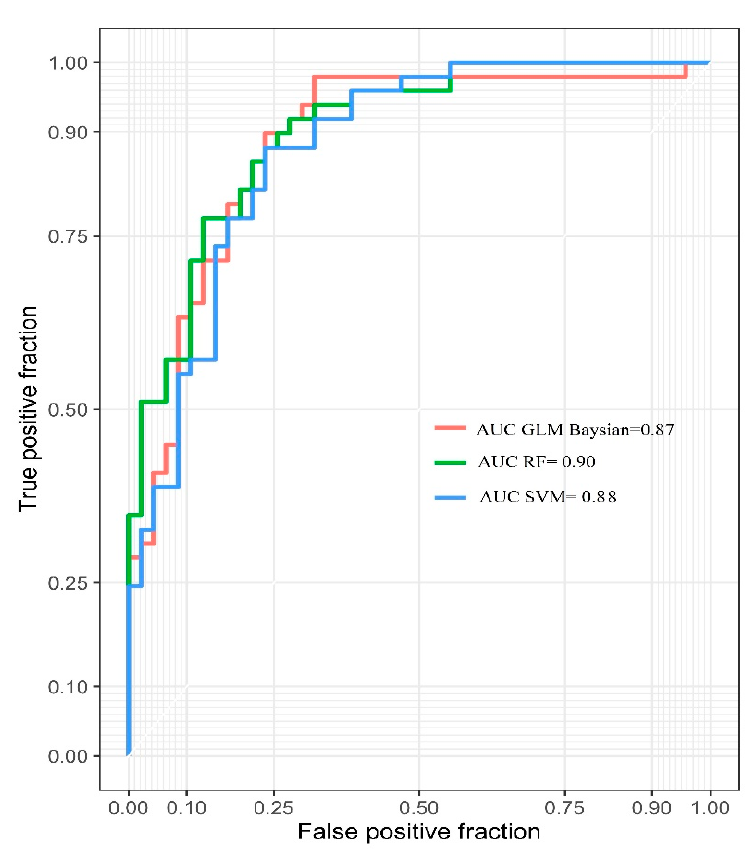
Figure 7. The ROC curve analysis for three piping models using the testing dataset.